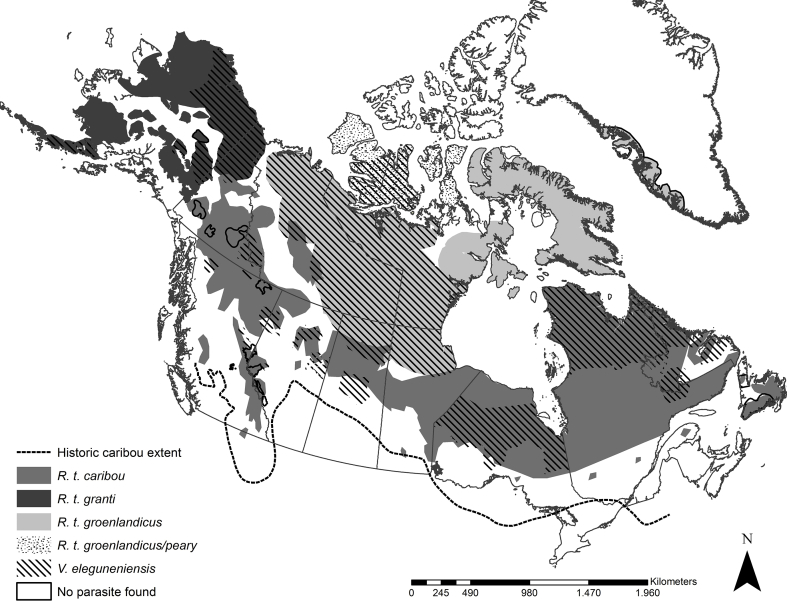
Map of Northern North America, including Alaska, USA, Canada and Greenland depicting the geographic distribution of caribou subspecies (Rangifer tarandus sspp.). The distribution of the caribou lungworm, Varestrongylus eleguneniensis in caribou is shown based on compiled data from the present study, and all reports in the literature (Kutz et al., 2007, 2012; 2013; ; Kafle et al., 2017a, Kafle et al., 2017; Turgeon et al., 2018). The historic southern range of distribution of caribou is shown as a dotted line to assist in the discussions on the historical biogeography of V. eleguneniensis and Rangifer.